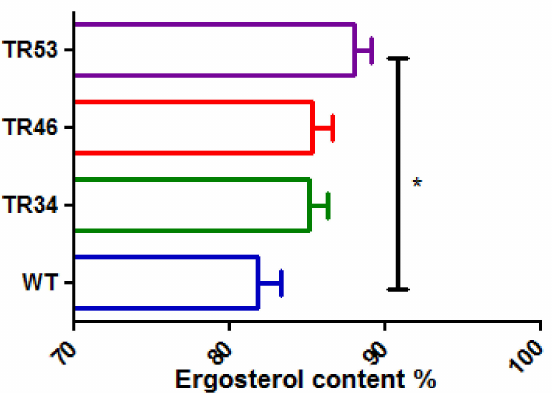
Figure 3. Relative content of ergosterol in basal condition. WT: susceptible isolates, TR34: TR 34 /L98H, TR46: TR 46 /Y121F/T289A. * p = 0.006 (Mann Whitney